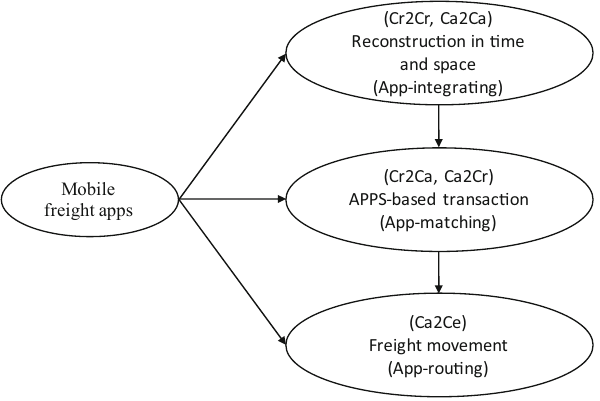
Fig. 4 Freight apps and freight movement system